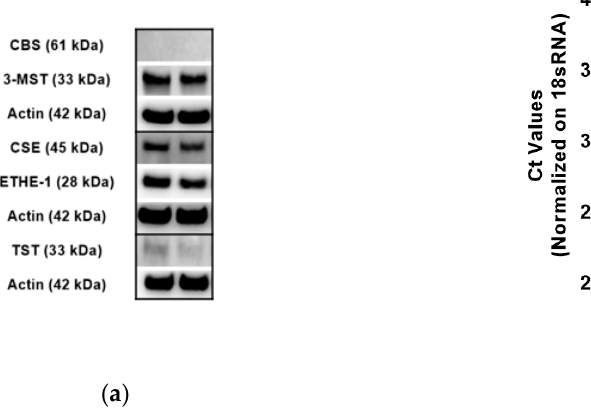
Figure 1. Qualitative detection of H 2 S pathway enzymes in CT26 cells at RNA and protein levels: ( a ) Representative Western blot of cystathionine-beta-synthase (CBS), 3-mercaptopyruvate sulfurtransferase (3-MST), cystathionine-gamma-lyase (CSE), ETHE-1, and TST in mouse colon carcinoma CT26 cell lysates; ( b ) Ct values from RT-qPCR amplification curves of CT26 cDNA with primers for mouse CBS, CSE, 3-MST, ETHE-1, and TST. Ct value of 18sRNA amplification was used for normalization. Single values are given by dots and corresponding mean ± SEM by lines. ND indicates non-detectable amplification.